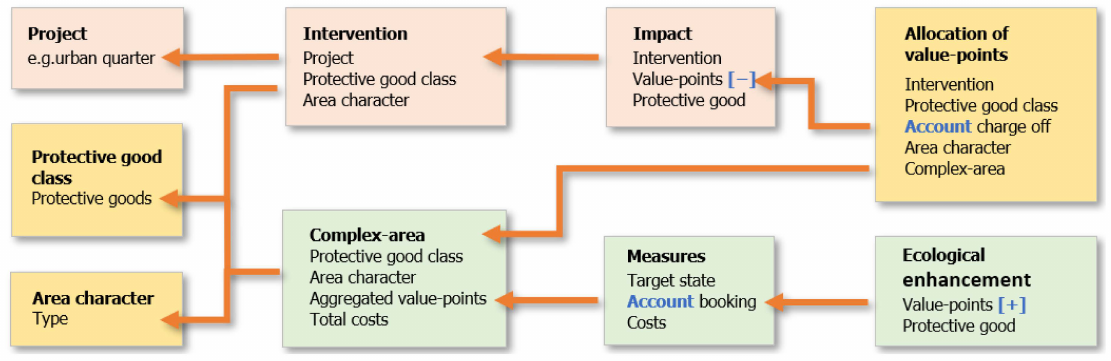
Figure 4. Simplified scheme for allocating ecological enhancements to interventions through value points in a land-use planning eco-account (LUP-EA); compensation required for species protection and legally protected biotopes is not included in this